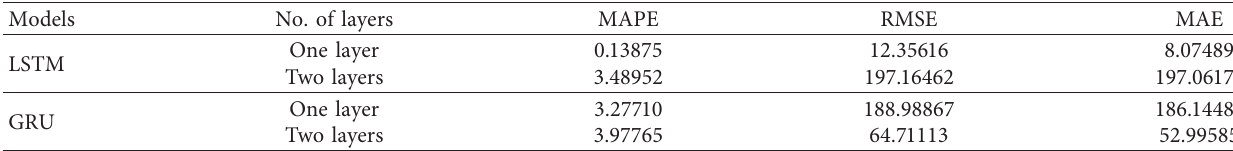
Table 9: The results of DL for death cases in Saudi